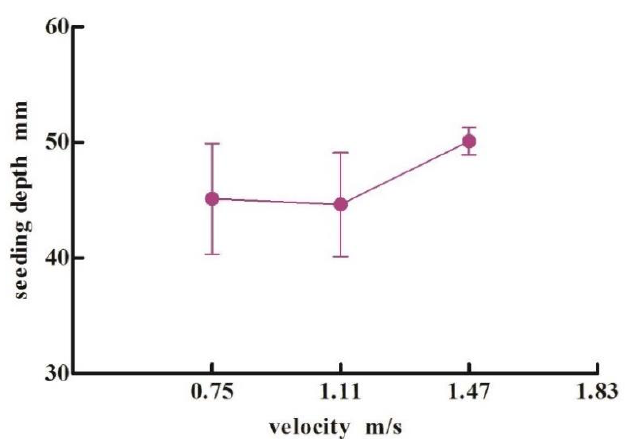
Figure 7. The influence of the soil compacting processing on the changes in seed displacement with various forward velocities.